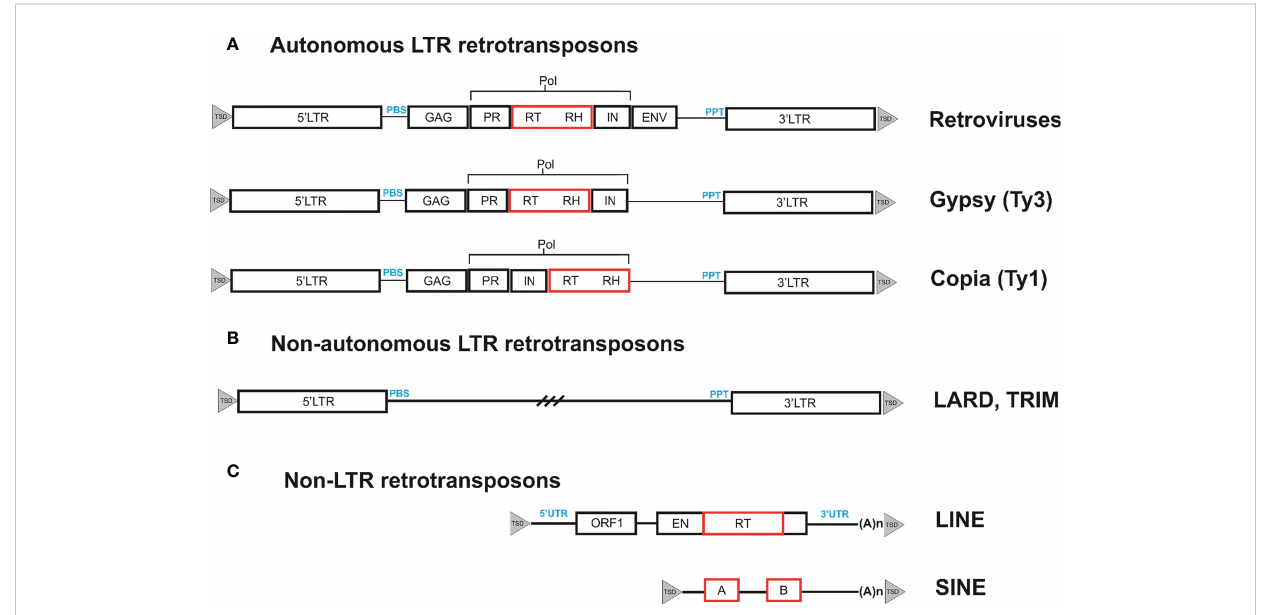
FIGURE 1 Organization of different types of retrotransposons. (A) . Retrotransposons can be classi fi ed based on their structural features. One such type is bounded by long terminal repeats (LTRs), which contain the transcriptional promoter and terminator. These LTRs contain short inverted repeats at either end, shown as fi lled triangles. During reverse transcription, the primer binding site (PBS) and polypurine tract (PPT) domains prime the synthesis of the complementary DNA (cDNA) strand on the ( − ) and (+) strands, respectively. The internal region of the retrotransposon codes for the proteins necessary for the retrotransposon life cycle. These include the capsid protein (GAG), the aspartic proteinase (AP) that cleaves the polyprotein (AP), the integrase (IN) that inserts the cDNA copy into the genome, and the reverse transcriptase (RT) and RNaseH (RH) that together copy the transcript into cDNA. The internal region also contains evolutionarily conserved domains (noted below the element as black boxes) that are necessary for function and can be used to isolate retrotransposons from previously unstudied plant species. These conserved domains can be targeted for ampli fi cation and sequencing of retrotransposons from a variety of species. The LTRs are generally well-conserved within families and can serve as targets for primer design to generate DNA footprints. DNA footprints are useful for studying the evolutionary history and diversity of retrotransposons within and between species. (B) . Non-autonomous LTR retrotransposons have two types of non-autonomous forms: Terminal- Repeat Retrotransposons in Miniature (TRIMs) and Large Retrotransposon Derivatives (LARDs). (C) Non-LTR retrotransposons, such as LINEs and SINEs, are terminated by a 3 ′ poly(A) stretch. LINEs have two open reading frames (ORFs) that encode a nucleocapsid protein (gag), an endonuclease (EN), and a reverse transcriptase (RT). The ORFs are fl anked by untranslated regions (UTR), with the broken line indicating the 5 ′ truncations found in many LINEs. SINEs are composed of a tRNA-derived region, an unrelated DNA sequence. The two black boxes labeled A and B depict regions with homology to RNA polymerase III